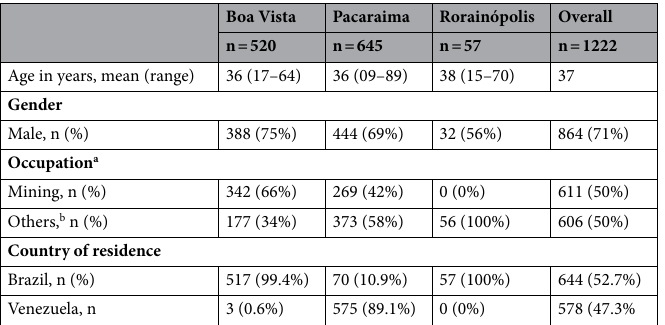
Table 1. Characteristics of study participants (n = 1222). a Occupation reported for 1217 participants (missing 1 from Boa Vista, 3 from Pacaraima and 1 from Rorainópolis). b Others: students, lawyers, housewives, drivers, cooks, salesmen, working in agriculture sector, and merchants.